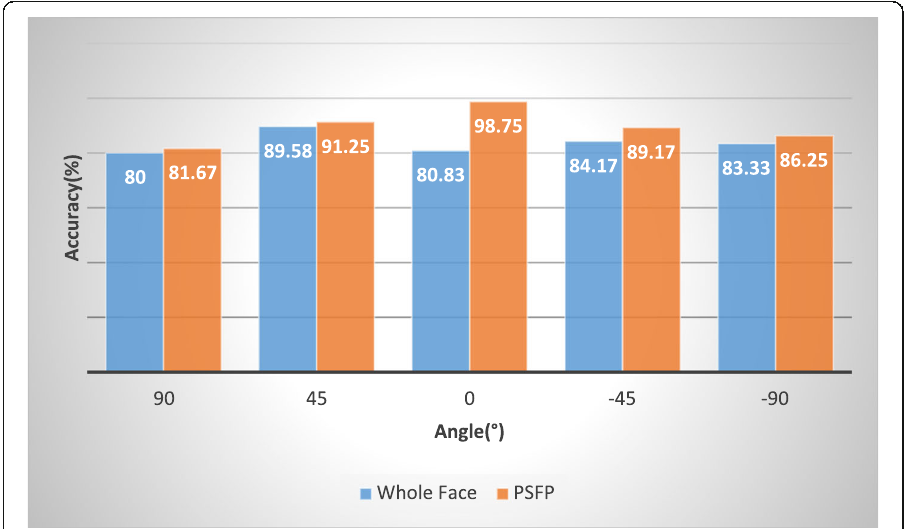
Fig. 12 Recognition rates for person-independent facial expression